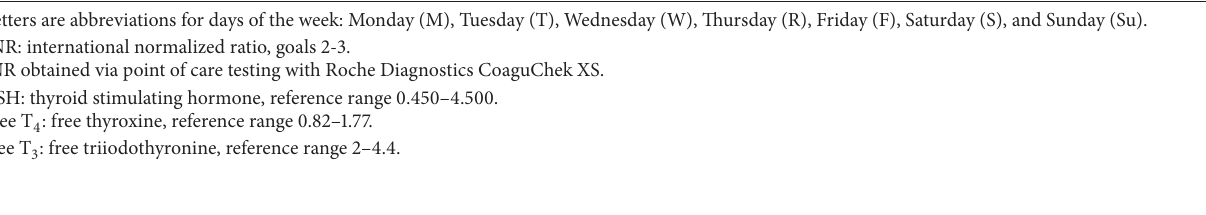
Table 4: Response to warfarin after levothyroxine